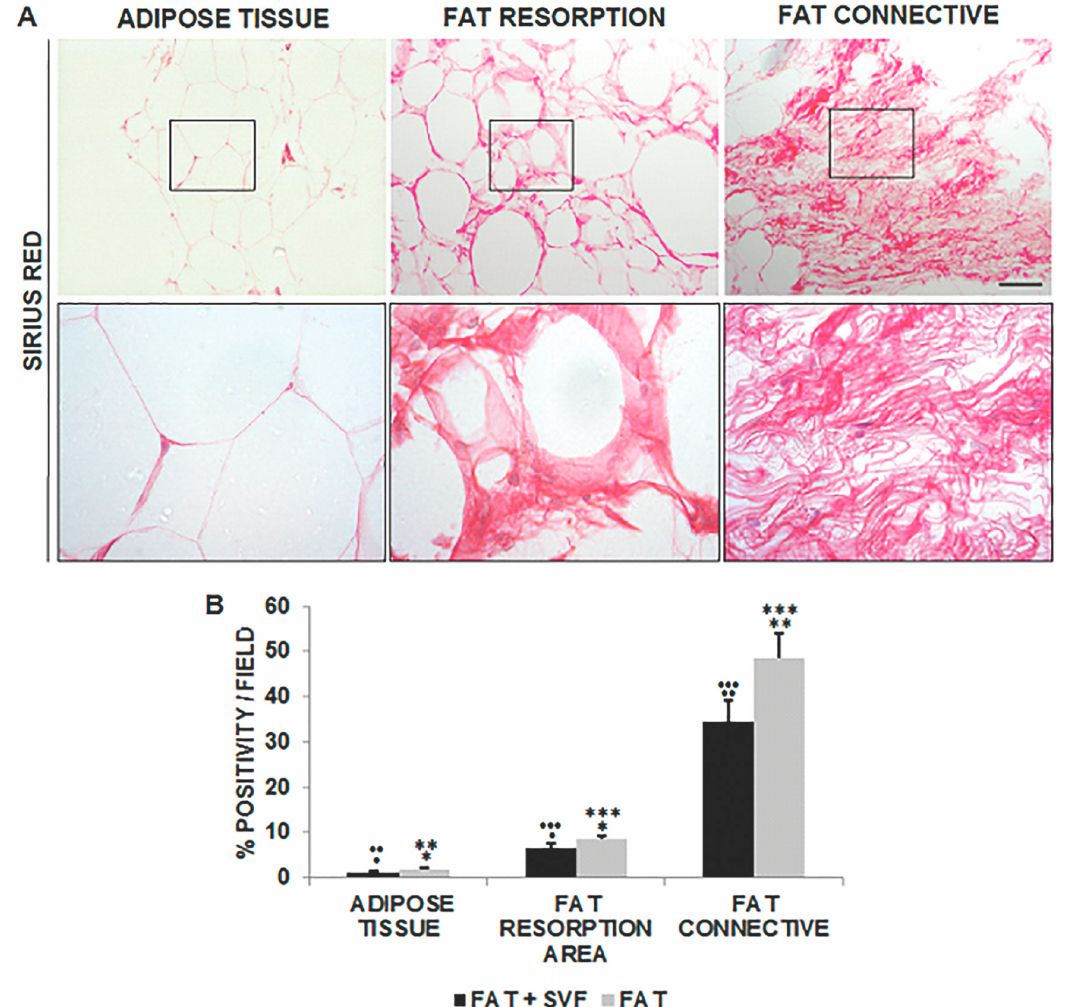
Figure 7. Images of Sirius red stained sections (100 × magnification and inset 400 × ) displaying the histological features of AT ( A , left panel and inset), reabsorption area ( A , middle panel and inset) and CT ( A , right panel and inset). The intense red color marked the dense connective areas inside the samples, while the other parenchymal tissue appeared rose in color. This latter feature (rose) has been excluded from the analyses because it is not indicative of collagen deposition. Thus, Sirius red quantification was performed for each of the distinct fat features / areas in the two groups. Data were reported in ( B ). The statistical symbols * , ** , *** and • , •• , ••• indicate the maximum value and